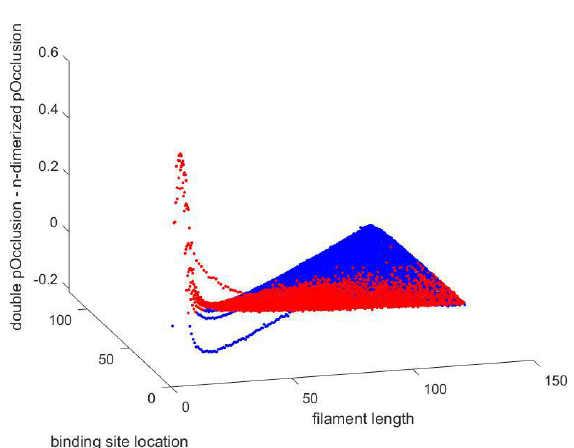
Figure 1. Cell size vs. number of cells.